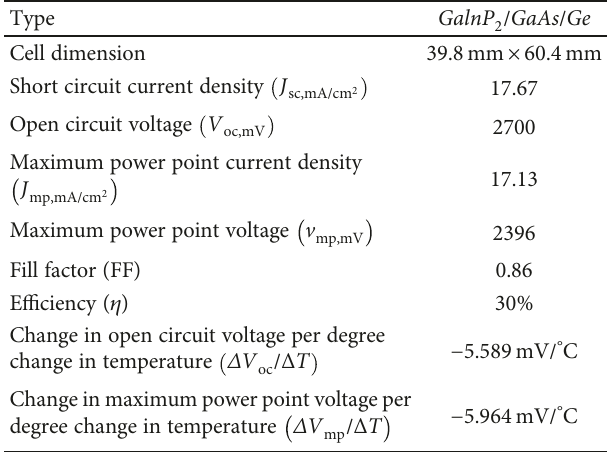
Table 1: GaAs triple-junction solar cell